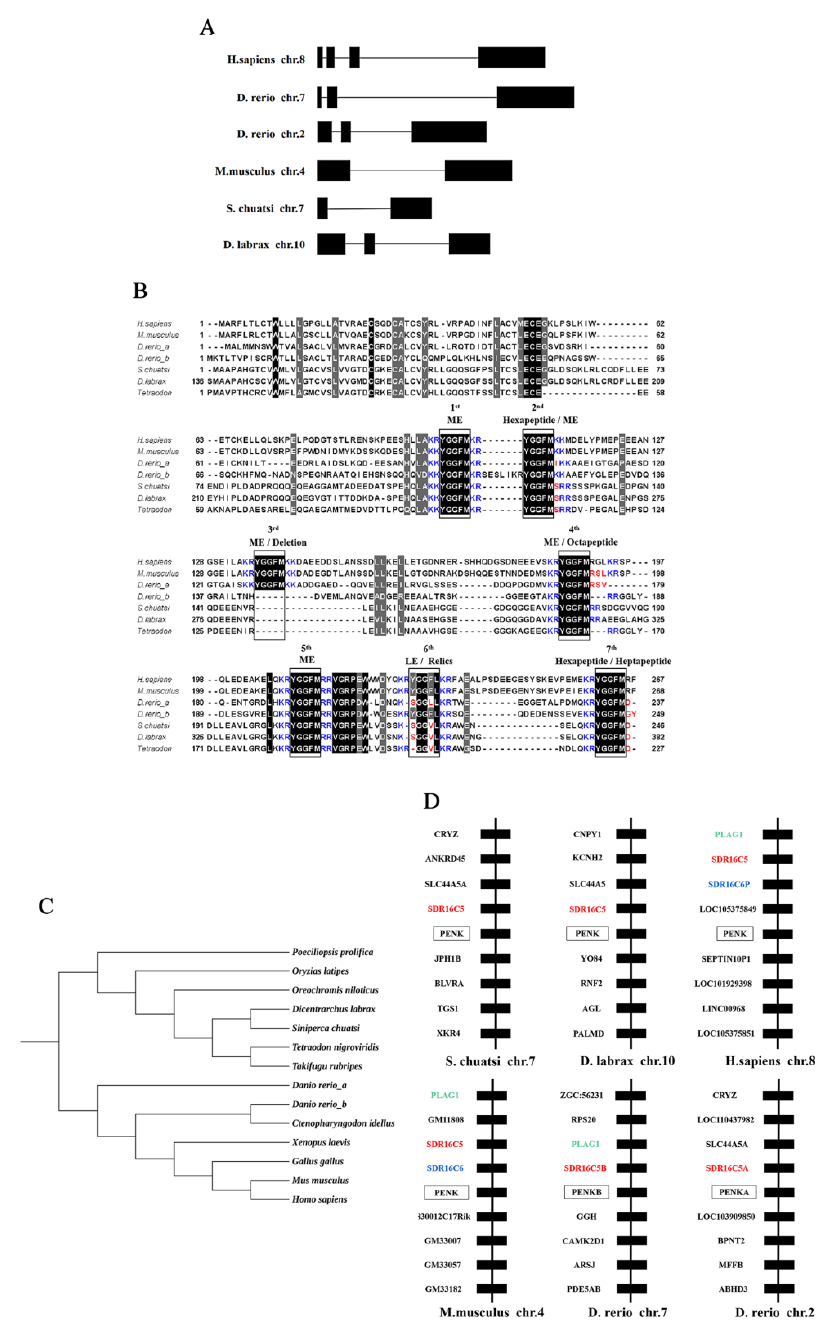
Figure 1. Bioinformatics analysis of PENK genes. ( A ) The structures of the PENK genes in human ( Homo sapiens ), mouse ( Mus musculus ), zebrafish ( Danio rerio ), mandarin fish ( Siniperca chuatsi ), and European seabass ( Dicentrarchus labrax ). The black squares represent exons, and the gray lines represent introns. ( B ) Sequence alignment of PENK in human ( Homo sapiens ), mouse ( Mus musculus ), mandarin fish ( Siniperca chuatsi ), zebrafish ( Danio rerio ), European seabass ( Dicentrarchus labrax ), and the green spotted puffer ( Tetraodon nigroviridis ). The core segments of the opioid are indicated by bold boxes. Mutated amino acid positions are indicated in red compared with human PENK. Intracellular protein cleavage sites are indicated in blue. ( C ) The evolutionary tree of PENK between mandarin fish ( Siniperca chuatsi ) and various species. ( D ) Synteny analysis of PENK genes in human ( Homo sapiens ), mandarin fish ( Siniperca chuatsi ), mouse ( Mus musculus ), European seabass ( Dicentrarchus labrax ), and zebrafish ( Danio rerio ). Among the species tested, those with common genes upstream and downstream of PENK in human are marked in colored text.